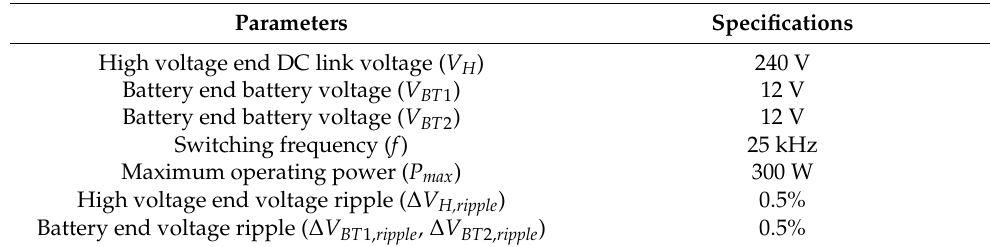
Table 1. The electricity specification of the bidirectional buck–boost soft-switching converter.